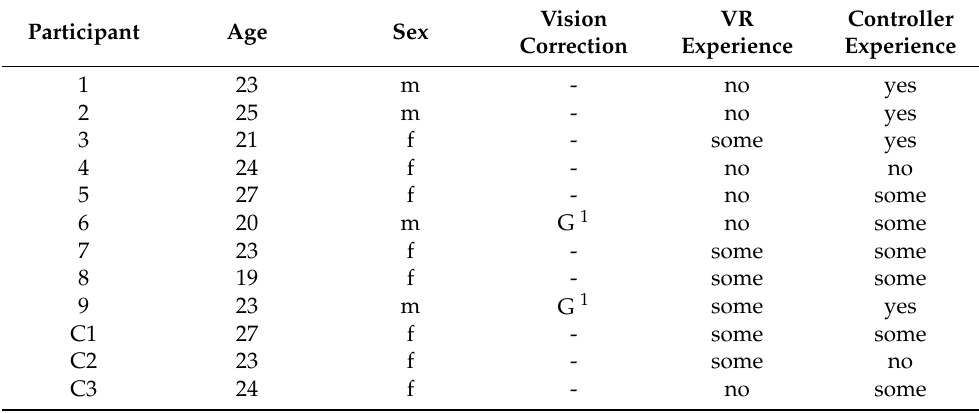
Table 1. Participant age, sex, vision correction as well as their previous experience with VR headsets and game controllers. A capital C marks participants of the control